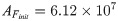
Sensitivity analysis to determine the effect of varying inhibitor adhesion kinetics upon treatment efficacy.For each panel, αA and βA = 10−12, 10−11, …, 10−1 and 1, where a log10 scale is used on both axes. The value of log10(BT(672)) is plotted at each point in parameter space, where BT(672) (= VBF(672) + ArBB(672)) is the total number of bacteria after 4 weeks (672 hr). The colour scheme is calibrated to maximise clarity, such that values of log10(BT(672)) ≤ −1 appear in black. The red curve (colour online) traces the contour along which BT(672) = 1, such that BT(672) > 1 to the left and BT(672) < 1 to the right of this curve. Treatment efficacy improves with increasing αA and decreasing βA. On average, treatment with a single inhibitor dose with continuous debridement is the most effective treatment, followed by regular inhibitor doses with regular debridement; a single inhibitor dose with regular debridement being the least effective of the three. Eqs 1–8 were solved using ode15s. AFinit=6.12×107 inhibitors cm−3 (the standard value). See Tables 1 and 2 for the remaining parameter values.